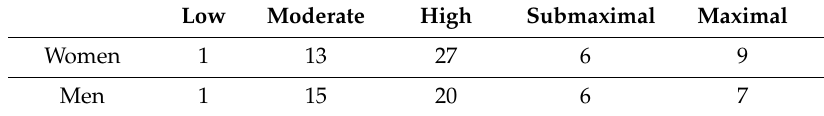
Table 1. Number of training sessions by intensity as noted by the coaches of the respective